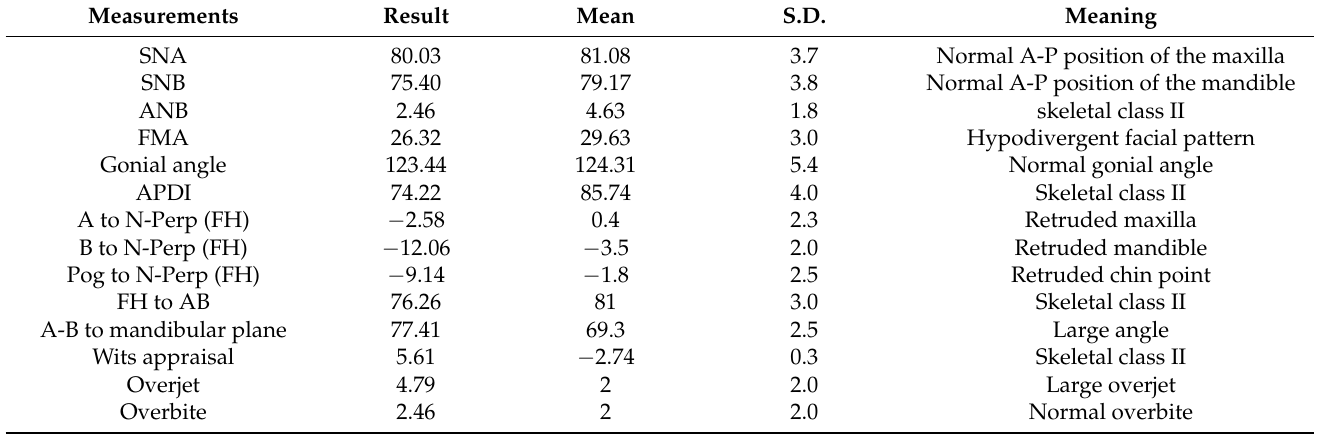
Figure 2. Lateral cephalogram. Table 4. Cephalometric tracing.